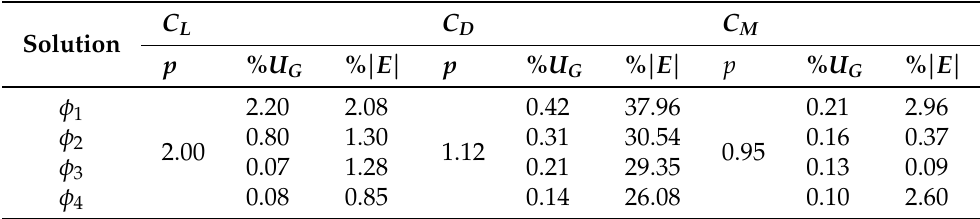
Table 10. Uncertainty estimations for H-mesh (log chord-wise spacings based on mesh